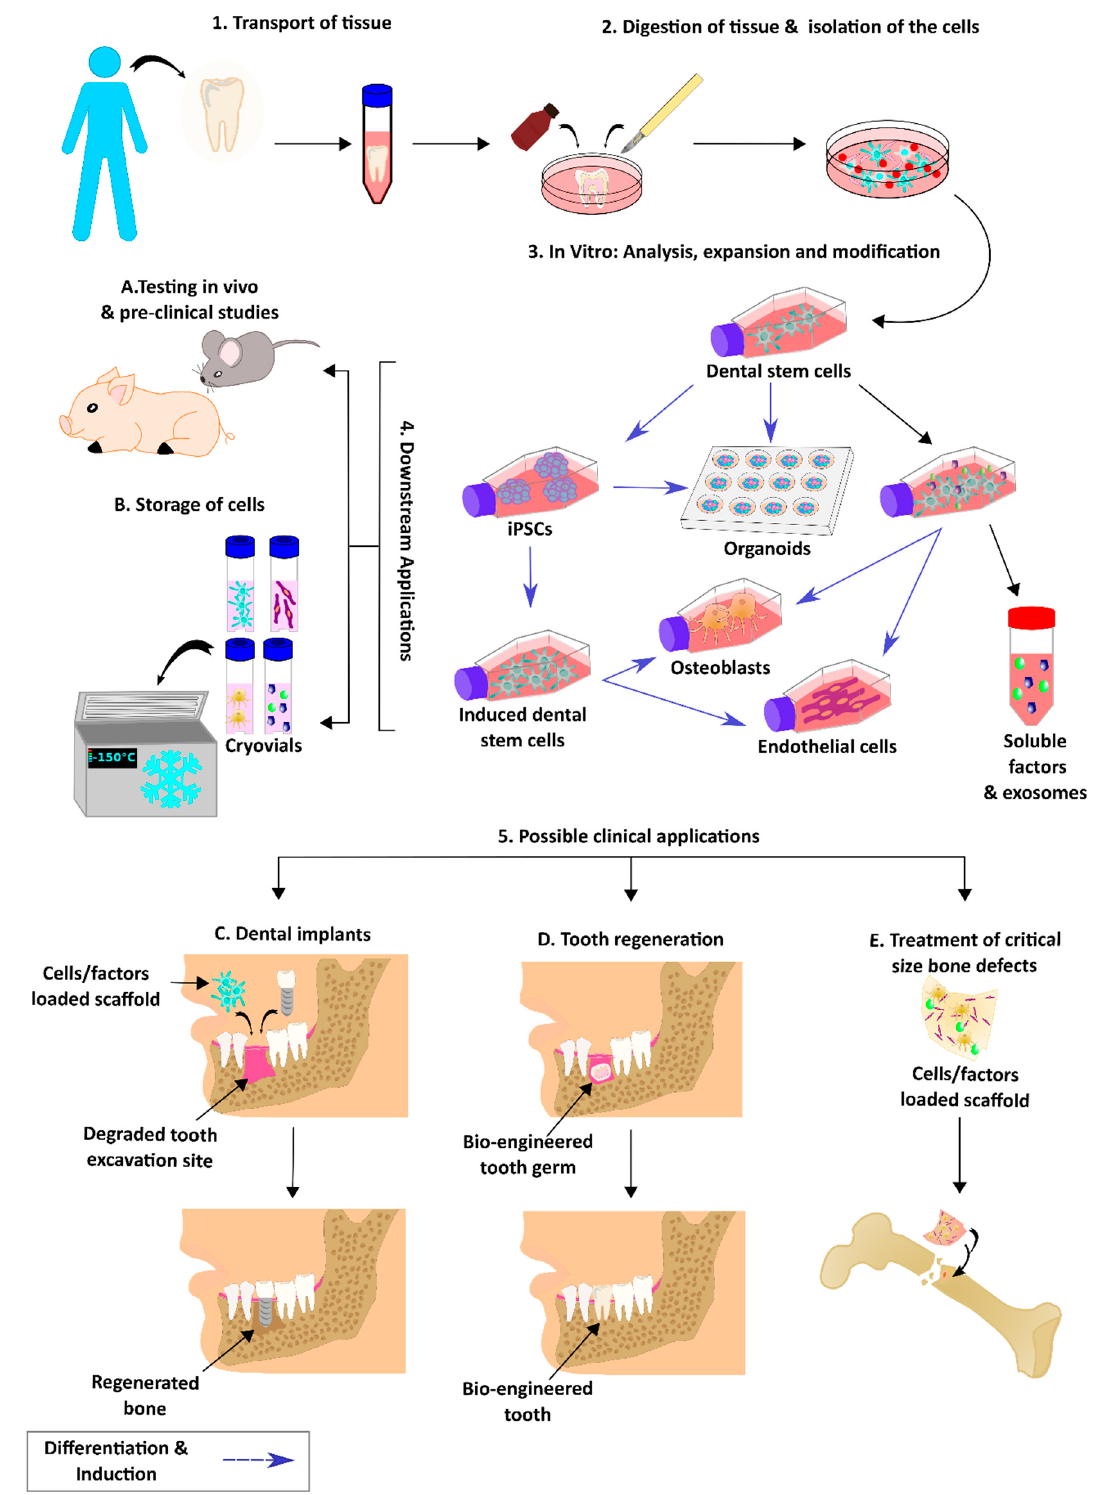
Figure 4. Possible applications of dental stem cells in research and therapy. Dental tissues are acquired from the patient ( 1 ) to isolate the dental stem cells ( 2 ); then, the DSCs can produce differentiate cell types ( 3 ), DSCs also produce soluble factors and exosomes. Then, the factors and exosome are characterized and tested in vivo ( A ), after which they are cryopreserved for future use ( B ) in ( 4 ) possible future therapy applications ( 5 ) such as for improving dental implants ( C ), whole tooth regeneration ( D ) and treatment of sever bone injuries like critical size bone defects ( E ).